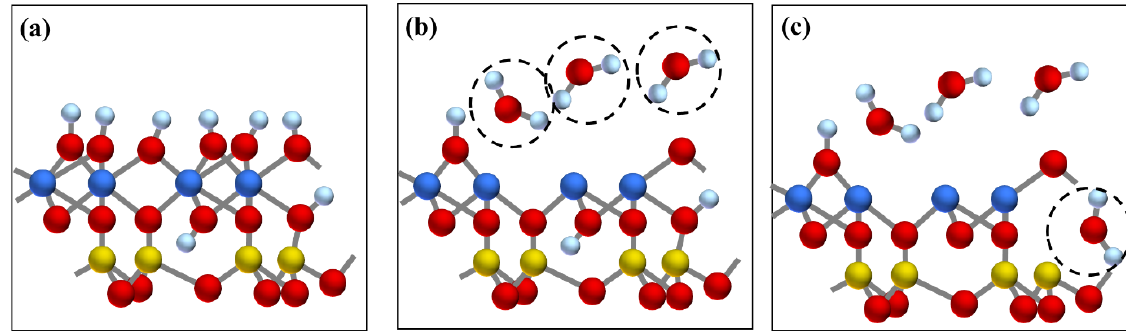
Figure 8. The mechanism schematic diagram of the transformation from kaolinite to metakaolinite by dehydroxylation: ( a ) layer structure of kaolinite, ( b ) escape of external hydroxyl group, ( c ) escape of internal hydroxyl group. Al, Si, O, and H atoms are represented by yellow, blue, red, and white spheres, respectively.